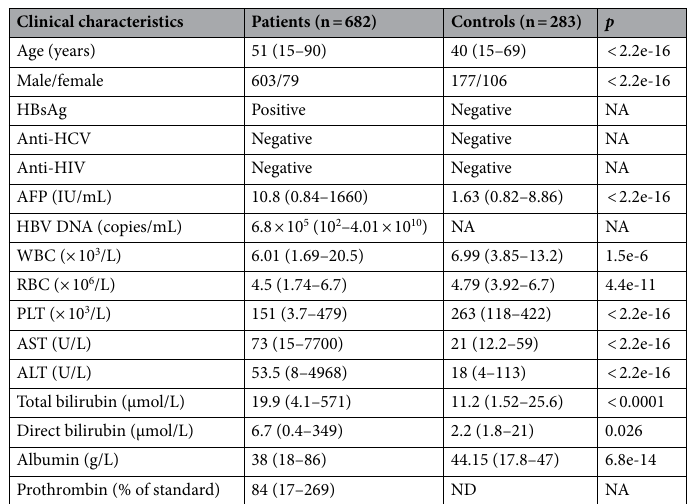
Table 1. Demographic and clinical characteristics of patients and controls. AFP aafa feto protei, AST and ALT aspartate and alanine amino transferase, WBC white blood cell, RBC red blood cell, PLT platelets. IU international unit, NA not applicable. Values given are median and range. P values were calculated by Mann– Whitney–Wilcoxon and Chi-squared test where